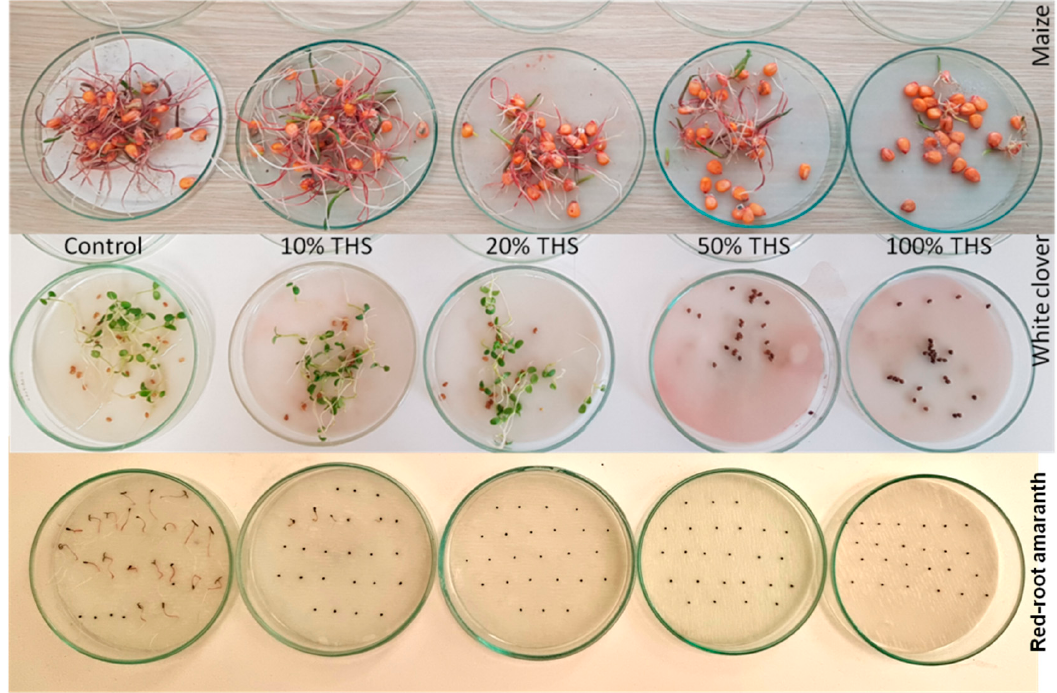
Figure 1. The effect of the applied T. vulgaris hydrolate solutions on maize and white clover.